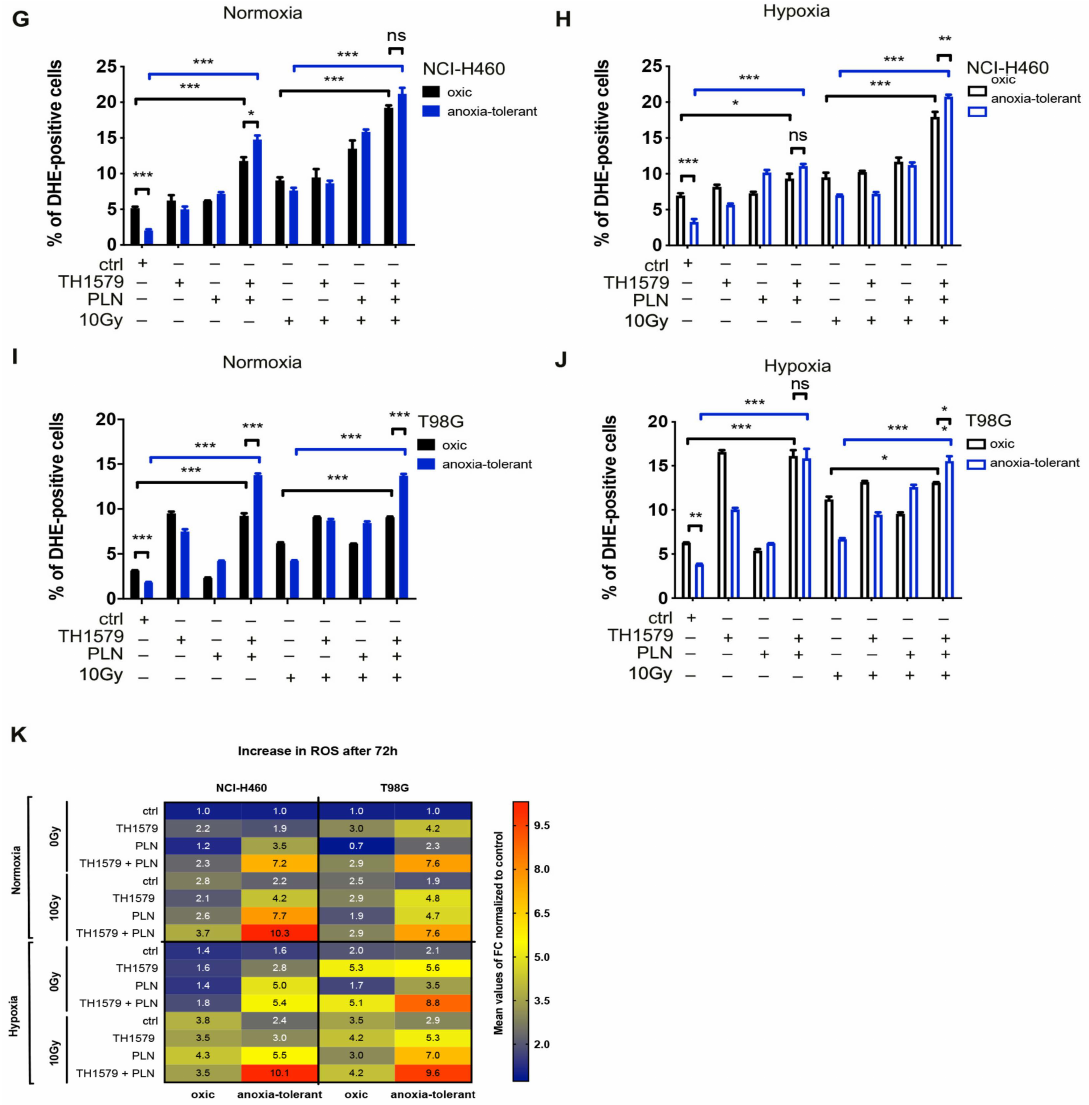
Figure 3. Exposure to IR or acute hypoxia triggers antioxidant defense which can be counteracted by inhibition of MTH1 and glutathione regeneration. Impact of IR and/or acute hypoxia on antioxidant capacity and ROS formation of oxic and anoxia-tolerant NCI-H460 and T98G cells and the potential of PLN and MTH1-inhibitor TH1579 for ROS modulation are shown. ( A ) GSH/GSSG ratios in NCI-H460 oxic and anoxia-tolerant cells 24 after exposure to 10 Gy IR, acute hypoxia or both. ( B , C ) GSH/GSSG ratios of NCI-H460 oxic and anoxia-tolerant cancer cells after 2 h of PLN (10 µ M)—or TH1579 (1 µ M)-treatment under normoxic ( B ) and hypoxic ( C ) conditions. ( D ) GSH/GSSG ratios in T98G oxic and anoxia-tolerant cells 24 h after exposure to 10 Gy IR, acute hypoxia or both. ( E , F ) GSH/GSSG ratios of T98G oxic and anoxia-tolerant cancer cells after 2 h of PLN—or TH1579 -treatment under normoxic ( E ) and hypoxic ( F ) conditions. ( G , H ) Fraction of DHE-positive cells stained for cellular ROS determined by flow cytometry in NCI-H460 oxic and anoxia-tolerant cells after 24 h of the respective treatments under normoxic ( G ) and severe hypoxic ( H ) conditions. ( I , J ) Fraction of DHE-positive cells stained for cellular ROS determined by flow cytometry in T98G oxic and anoxia-tolerant cells after 24 h of the respective treatments under normoxic ( I ) and severe hypoxic ( J ) conditions. ( K ) Representation of the treatment-induced increase in ROS in anoxia-tolerant and respective oxic control NCI-H460 and T98G cancer cells under normoxia and hypoxia. Measured ROS-levels were normalized to levels of untreated controls and represented as mean fold change (FC) in a heat map. Heat map indicating mean fold change of ROS induction in NCI-H460 or T98G oxic and anoxia-tolerant cells after 24 h of the respective treatments under normoxic and severe hypoxic conditions. Mean values ± SEM are shown, n = 3 (ns: not significant, * p ≤ 0.05, ** p ≤ 0.01, *** p ≤ 0.001, **** p ≤ 0.0001; 2-way ANOVA with Tukey